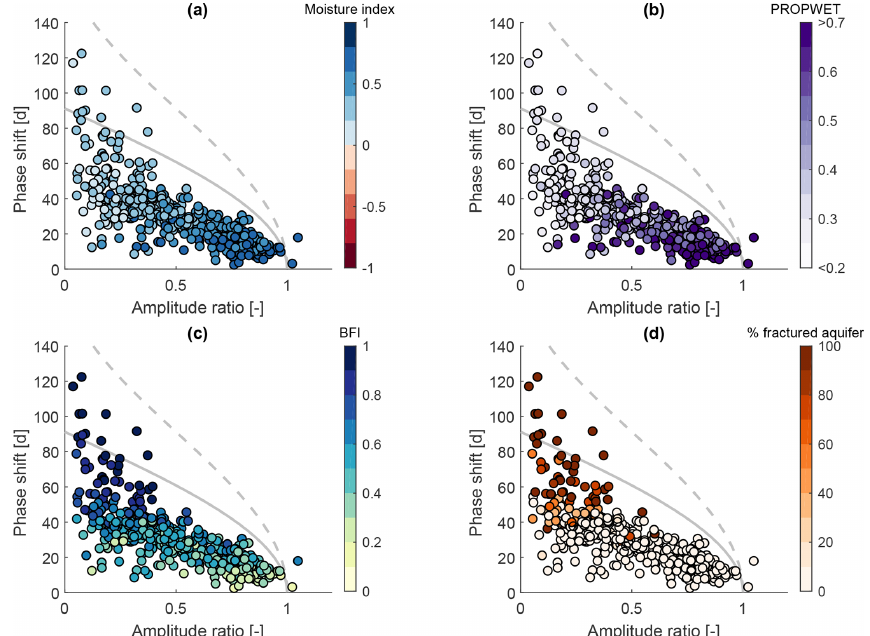
Figure 6. Amplitude ratio against phase shift for UK catchments. The grey solid line indicates a single linear reservoir, and the grey dashed line indicates the outer envelope for two reservoirs in parallel. Colours indicate (a) the moisture index, (b) the catchment wetness index, (c) the baseflow index, and (d) the fraction of highly productive fractured aquifer. Note that both axes are limited (two catchments are not